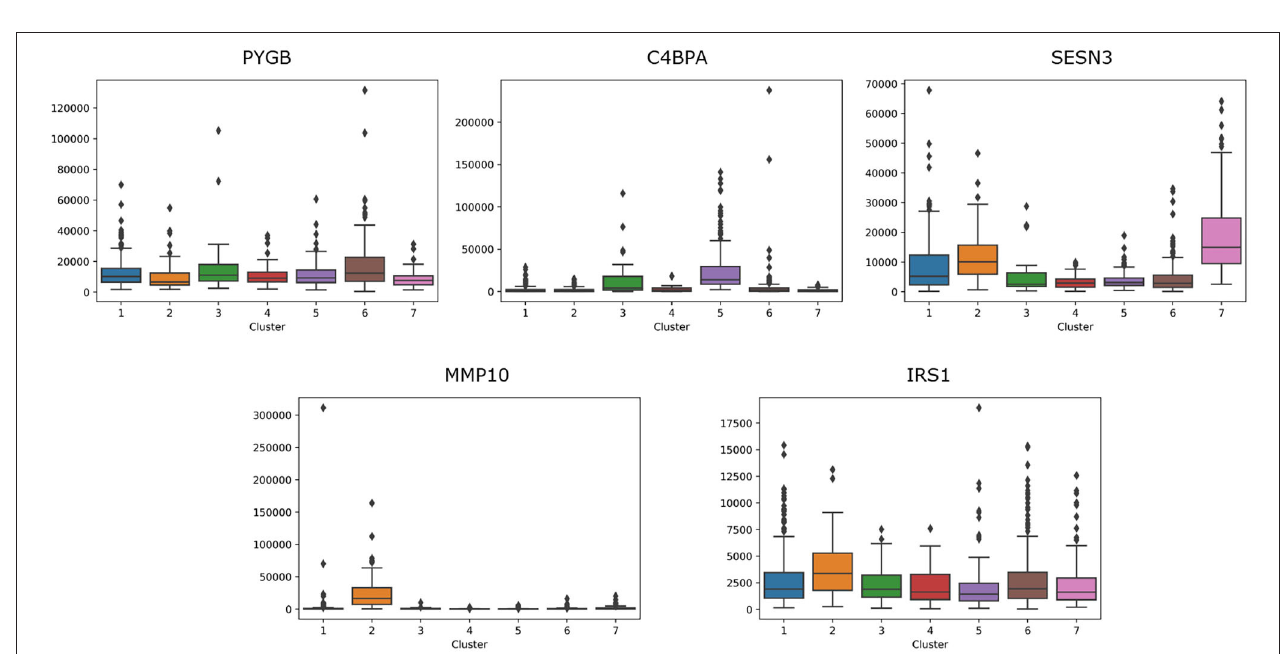
FIGURE 8 | The box plot of essential gene expression data for lung